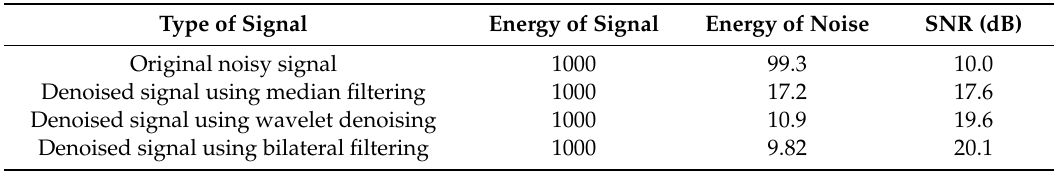
Table 1. Signal-to-noise ratio (SNR) of synthetic dual-frequency chirp